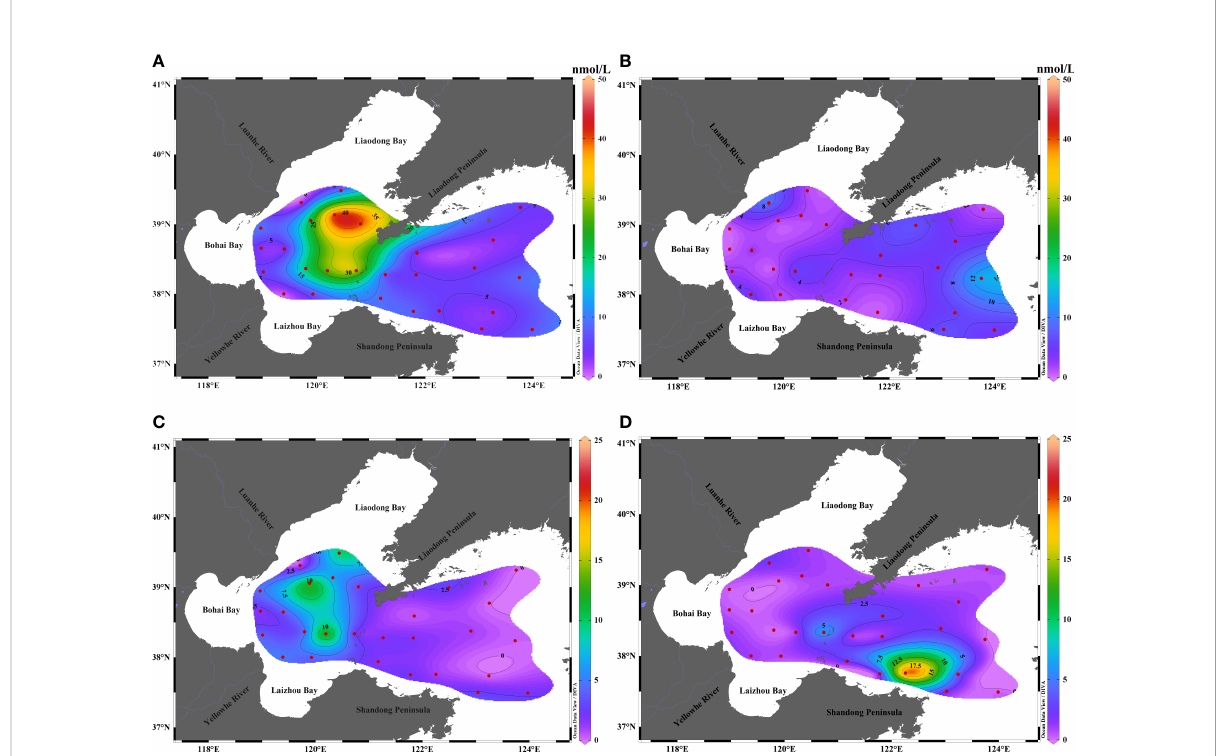
FIGURE 4 Horizontal distribution of DMSPp and DMSPd in the surface waters of BS and NYS in summer and autumn. Distribution of DMSPp in (A) summer and (B) autumn. Distribution of DMSPd in (C) summer and (D)